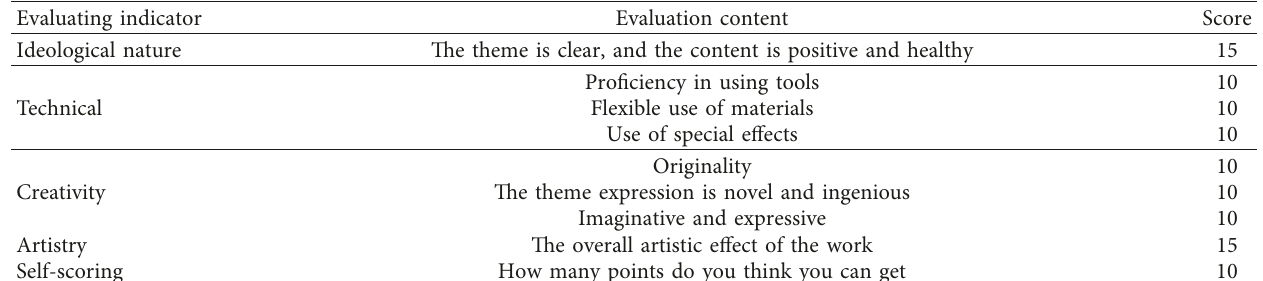
Table 13: Evaluation